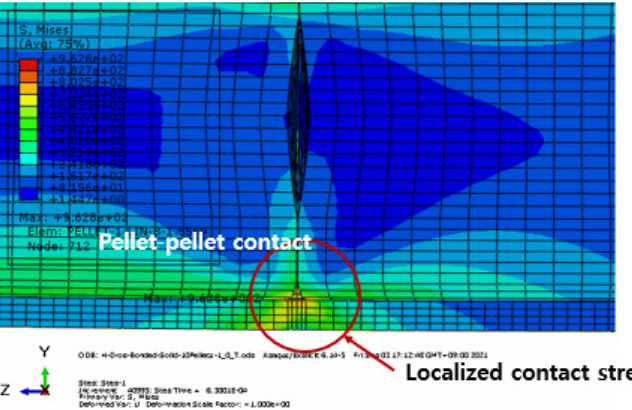
Figure 2. Effect of the pellet–pellet contact and pellet–clad interaction on the cladding strain.